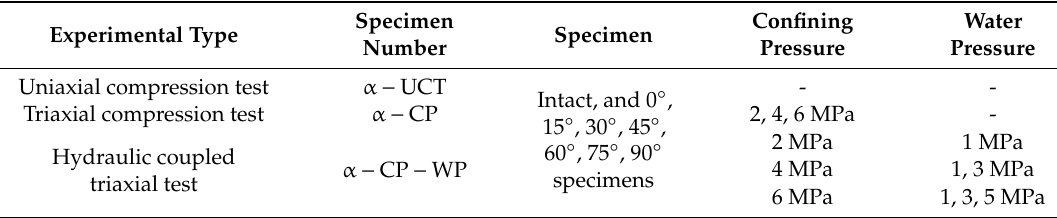
Confining Water Specimen Specimen Pressure Pressure Number